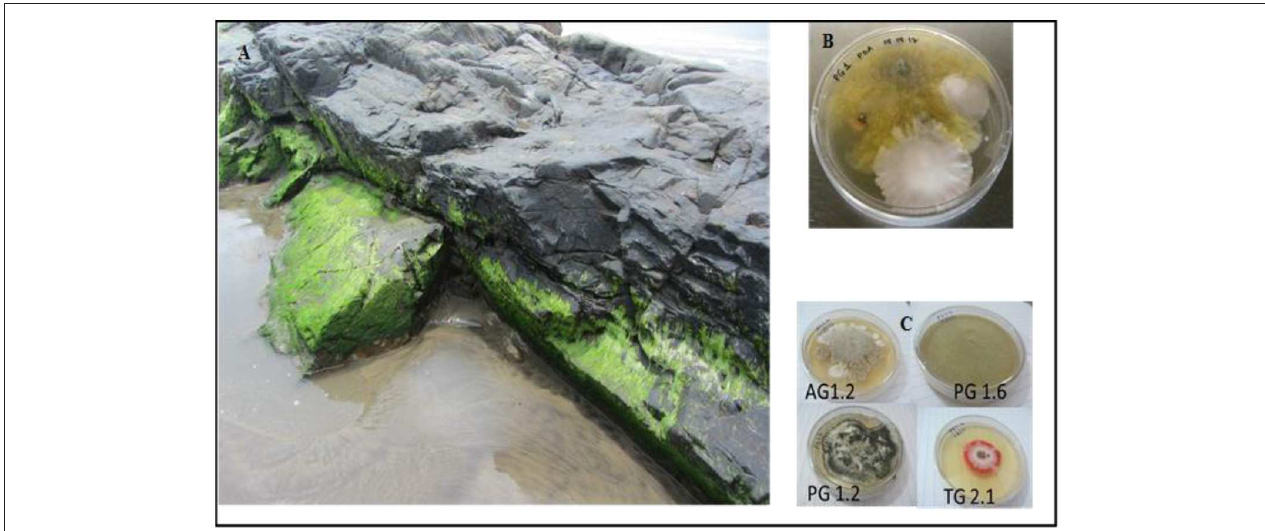
FIGURE 1 | Habitat of marine algae and its fungal endophytes. (A) Chaetomorpha sp. growing on the rocky shore of Vagator. (B) Fungal endophytes emerging from algal segments after 2 weeks on PDA plate. (C) Representative fungal morphophytes isolated from various marine algae growing on PDA for 7 days at 26 ◦ C.